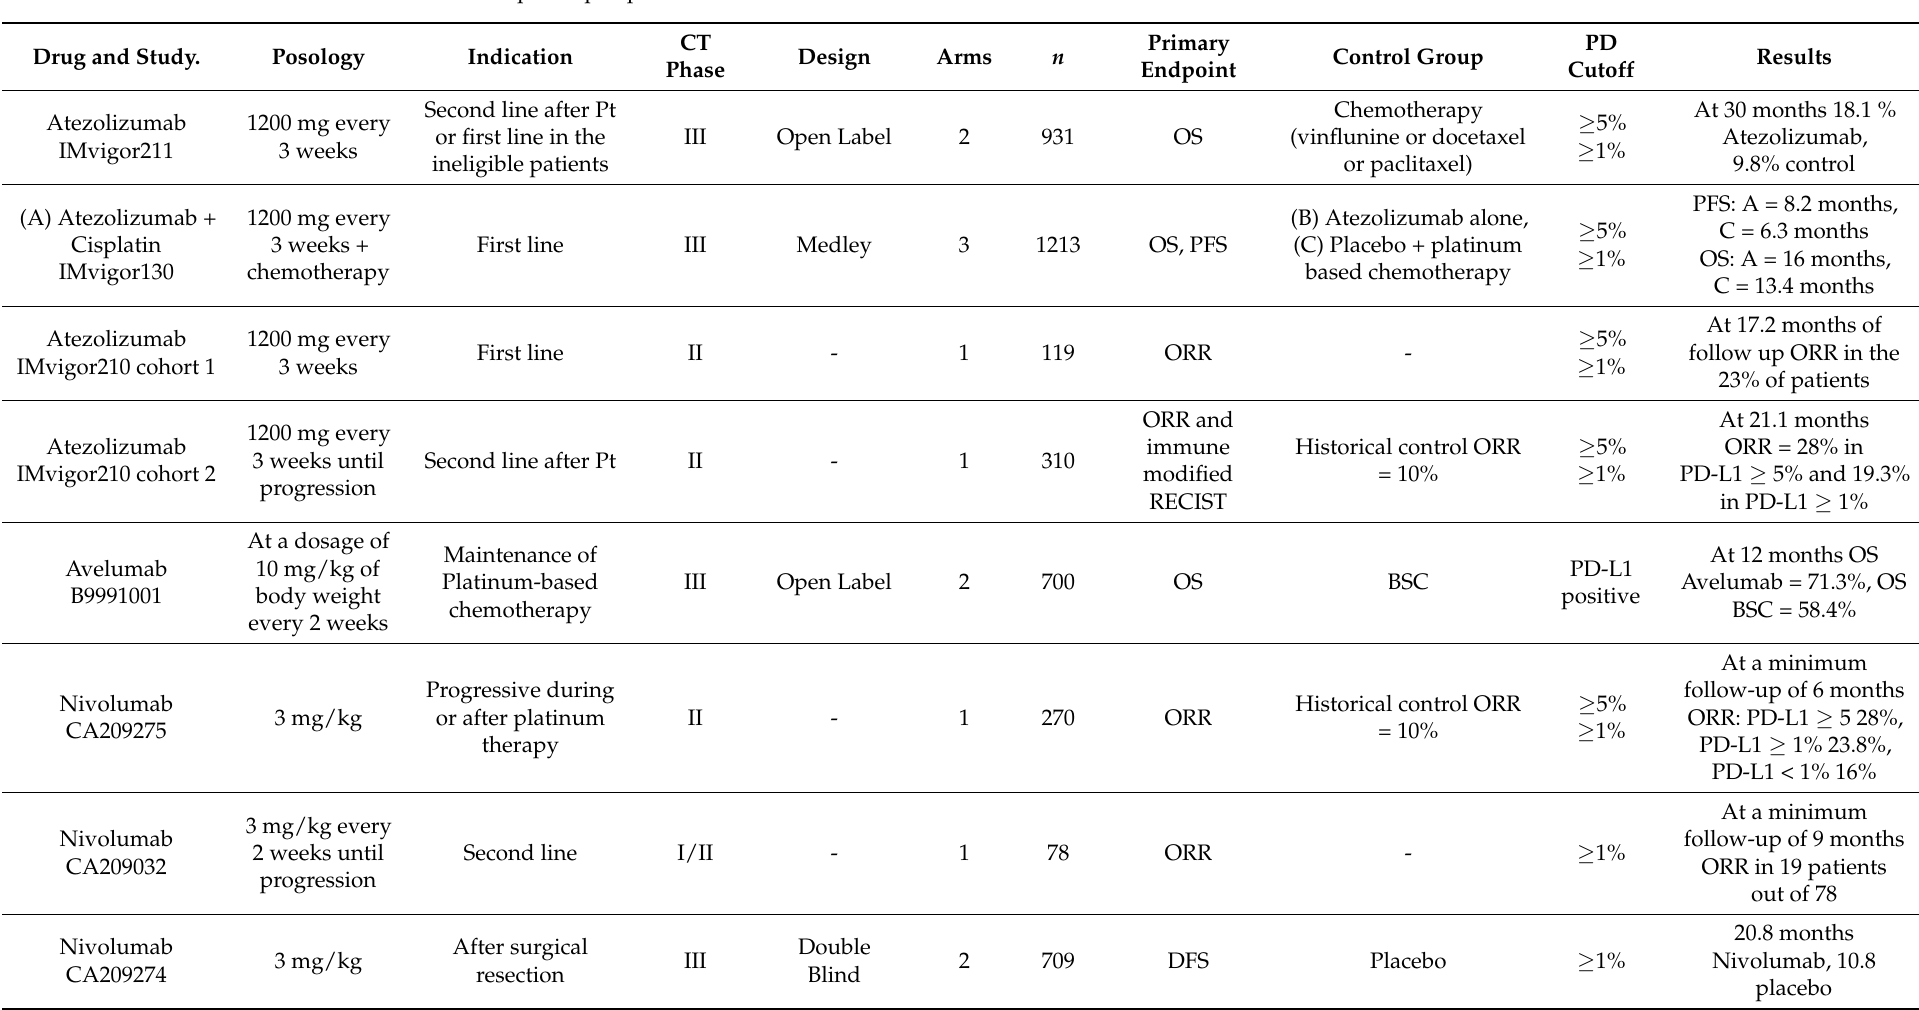
Table 1. New therapeutic